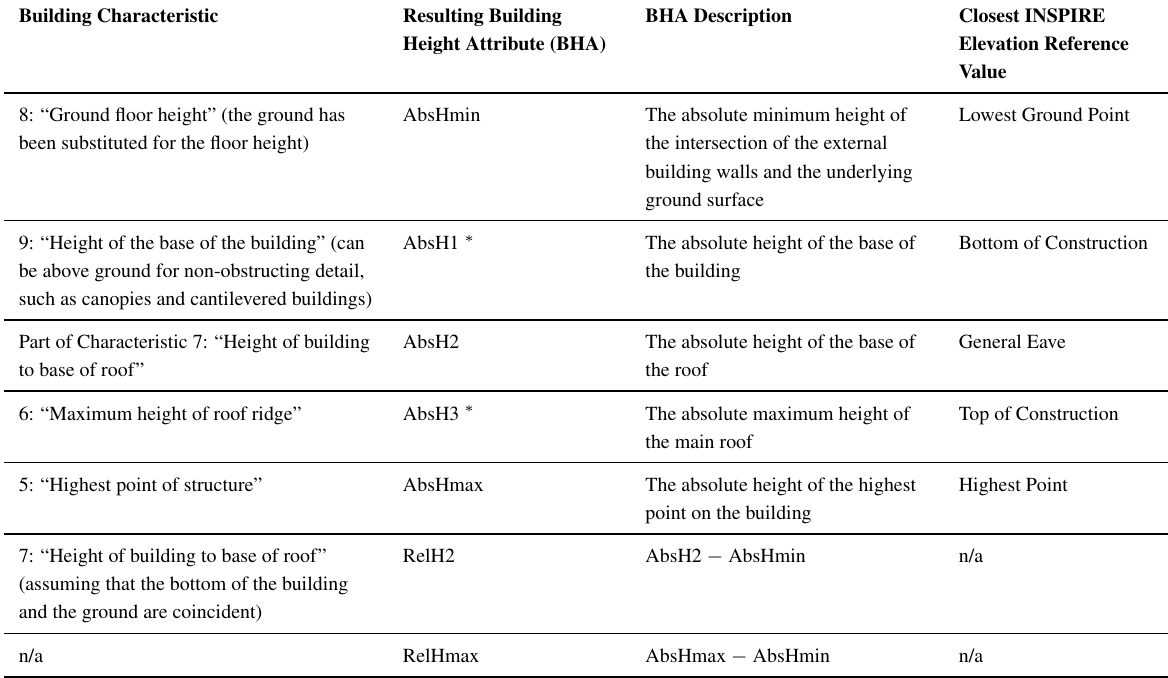
Table 2. Comparison of building height attributes, as available with the OS MasterMap Topography Layer, and the building height characteristics. INSPIRE Elevation Reference Values are included for